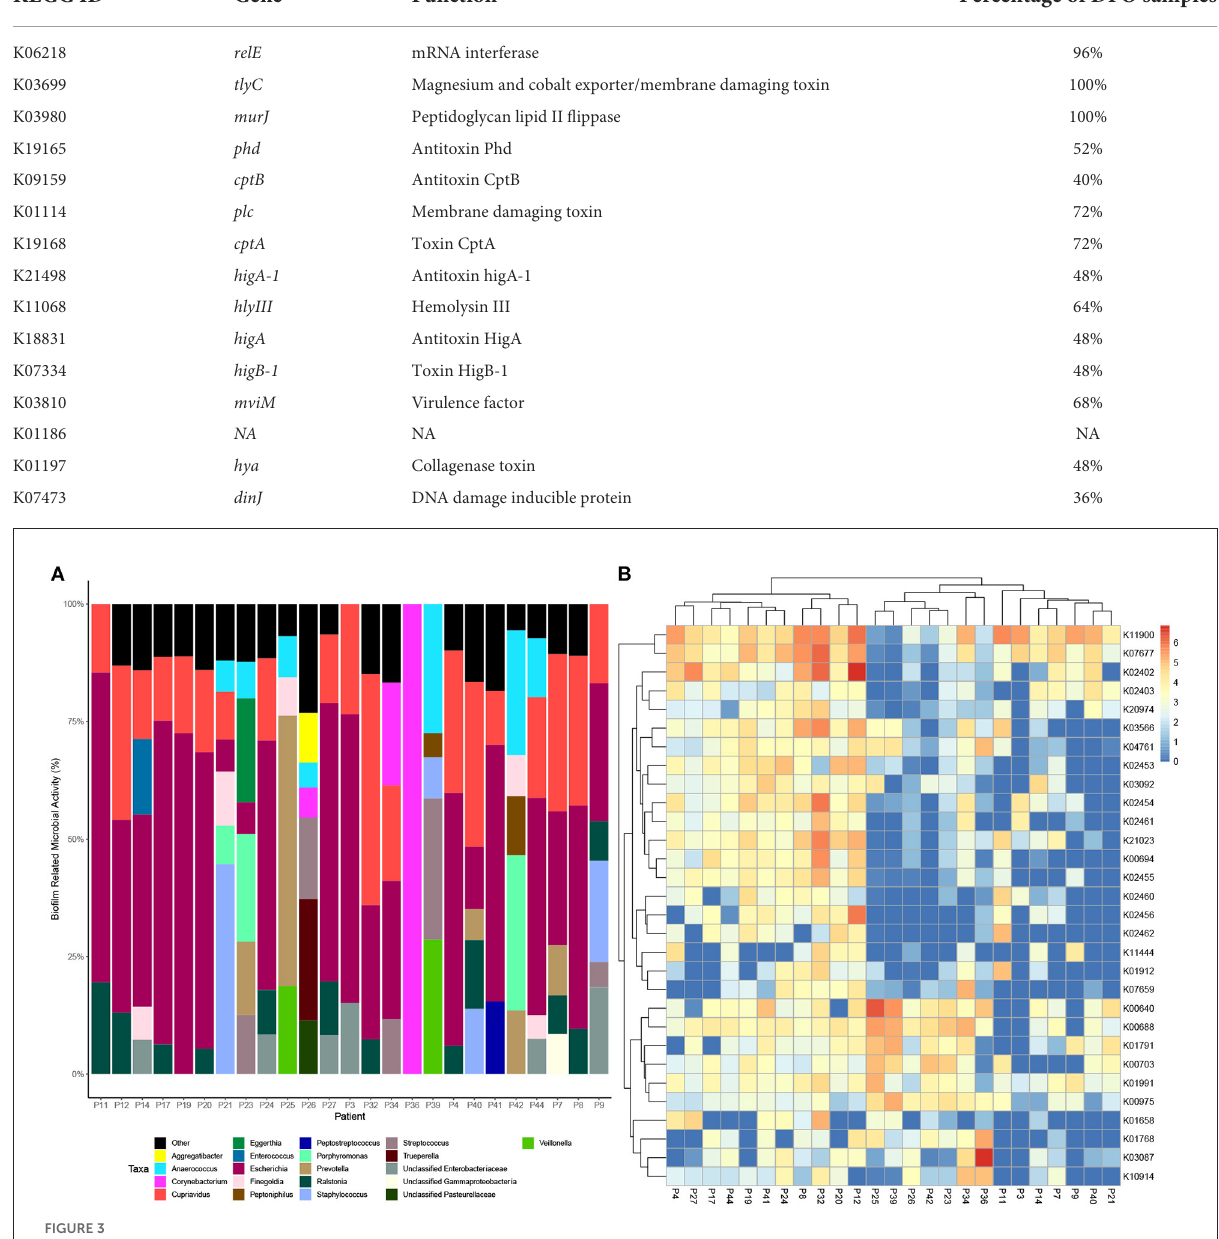
and overuse of orally administered amoxicillin/clavulanate may select resistance in Gram-negative pathogens (Veeraraghavan et al.,